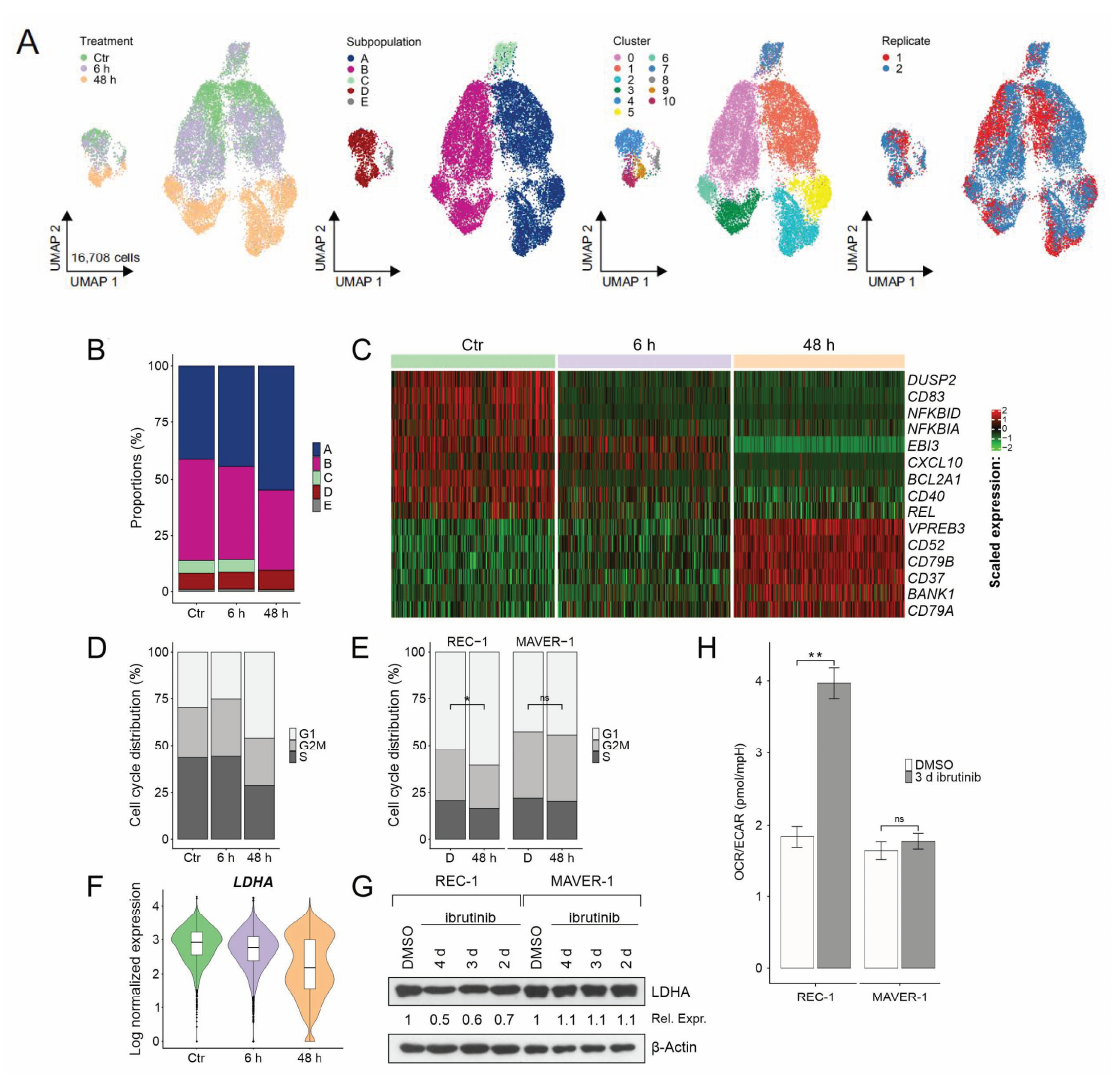
Figure 3. Evolution of subpopulations across ibrutinib treatment. ( A ) Uniform manifold approximation and projection (UMAP) representations of the combined data set including replicate 1 and 2 of Ctr, 6 h, and 48 h after cell cycle regression (clusters are shown for resolution 0.4 with additional subclustering of subpopulation D at resolution 0.3); ( B ) proportions of subpopulations across treatment; ( C ) heatmap of selected marker genes of Ctr, 6 h, and 48 h (see Table S3 for treatment markers); ( D ) distribution of predicted cell cycle phases (G1, G2/M, and S) across treatment by Seurat’s cell cycle scoring; ( E ) distribution of cell cycle phases acquired by flow cytometry (sensitive REC-1 compared to resistant MAVER-1 cell line, D = DMSO control, 48 h = 48 h 400 nM ibrutinib treatment; n = 3, * p ≤ 0.05, ns = not significant); ( F ) violin plot of LDHA expression levels of the single-cell sequencing data; ( G ) Western blot of LDHA expression after ibrutinib treatment (DMSO as control, 400 nM ibrutinib for 2 d, 3 d, and 4 d) in sensitive REC-1 and in resistant MAVER-1, β -actin served as loading control, relative expression (Rel. Expr.) to DMSO control was calculated after normalization to β -actin (Western blot and relative expression values are shown representative for three independent replicates); and ( H ) extracellular flux analysis of 3 d ibrutinib (400 nM) or DMSO (control) treated cells (sensitive REC-1 compared to resistant MAVER-1) by Agilent Seahorse XF 96 Analyzer; the ratio of oxygen consumption rate (OCR) to extracellular acidification rate (ECAR) is shown ( n = 3, ** p ≤ 0.005, ns = not